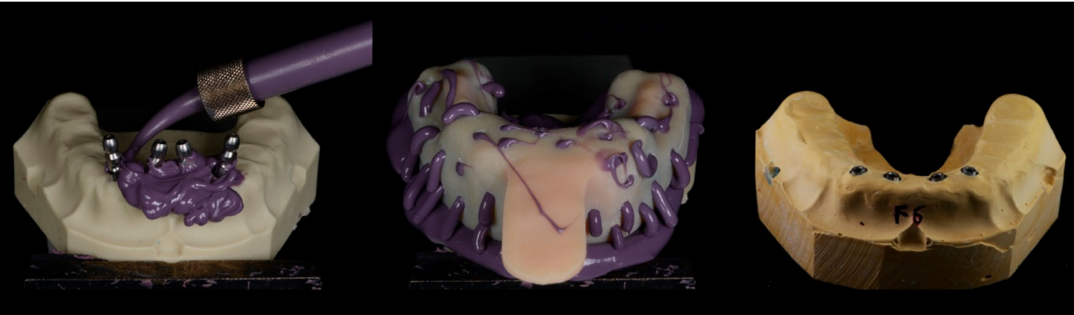
Figure 2. Impression protocol—obtaining study models.